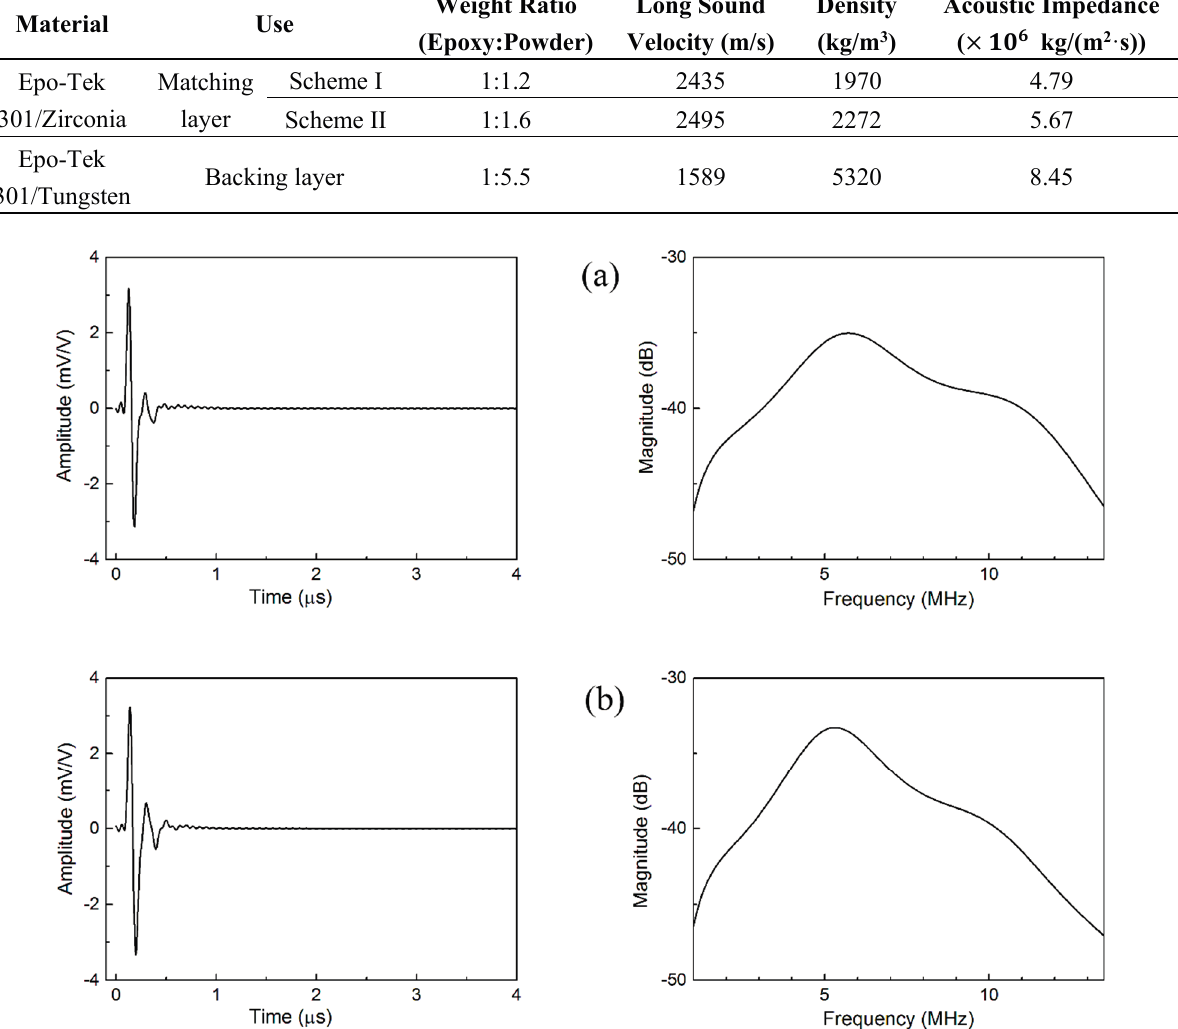
Table 2. The properties of the passive materials used for the TOFD transducer fabrication.